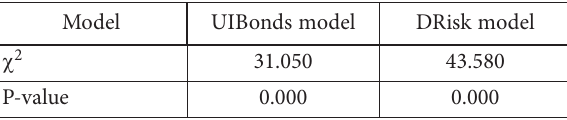
Table 3. Hausman test of random effects and fixed effect models Model